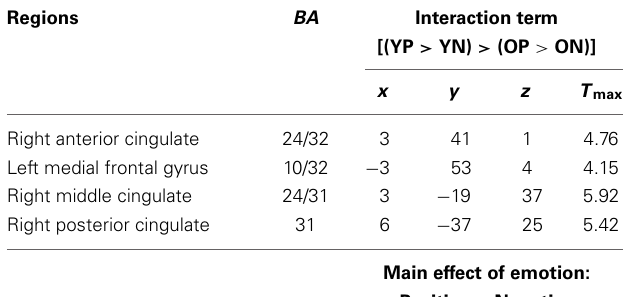
Table 4 | Relative increases in brain activity between positive and negative autobiographical memory retrieval in older and younger